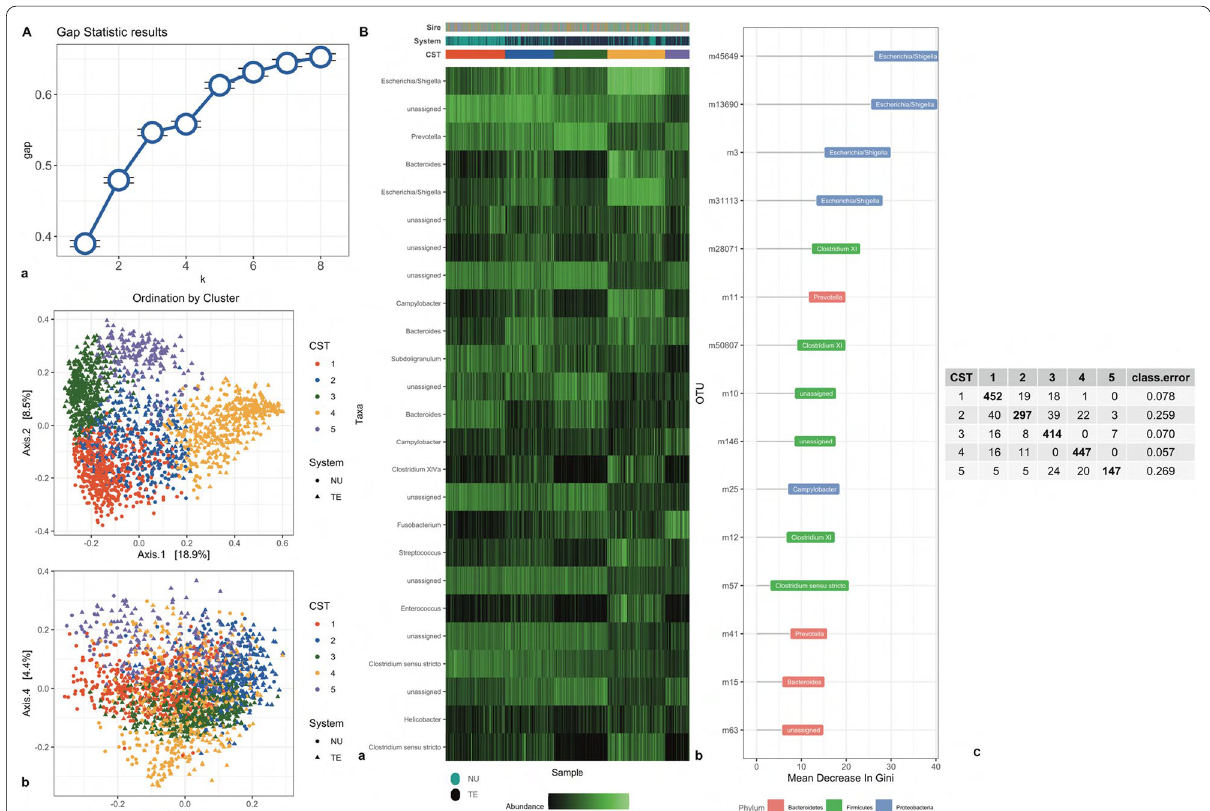
Fig. 3 Clustering analysis of gut microbiome for two systems at three time points. Clustering analysis of gut microbiome data collected for Purebred (NU) and Crossbred (TE) ( b ) at three time points: weaning (TP1), mid test (TP2), and off test (TP3) of the feeding trial. Gap statistic ( a , Subpanel a) and Principal Coordinates Analysis (PCoA) ( a , Subpanel, b). Genus representation ( b , subpanel a) and variable importance ( b , Subpanel b). Breed (TE, NU), CST (cluster 1–5). Confusion matrix ( b , Subpanel b). On the diagonal individuals classified in the correct cluster. Off diagonal number individuals misclassified to different clusters. The last column represents the error rate in